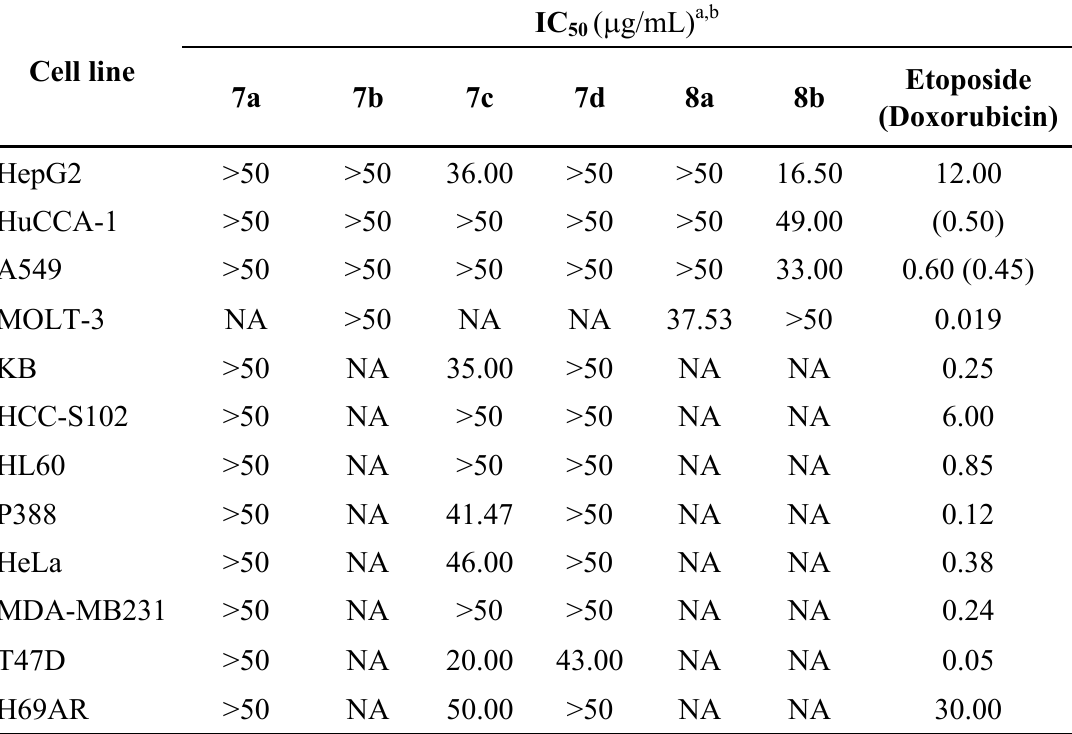
Table 4. Anticancer activity of substituted 5-iodouracils 7 and 8